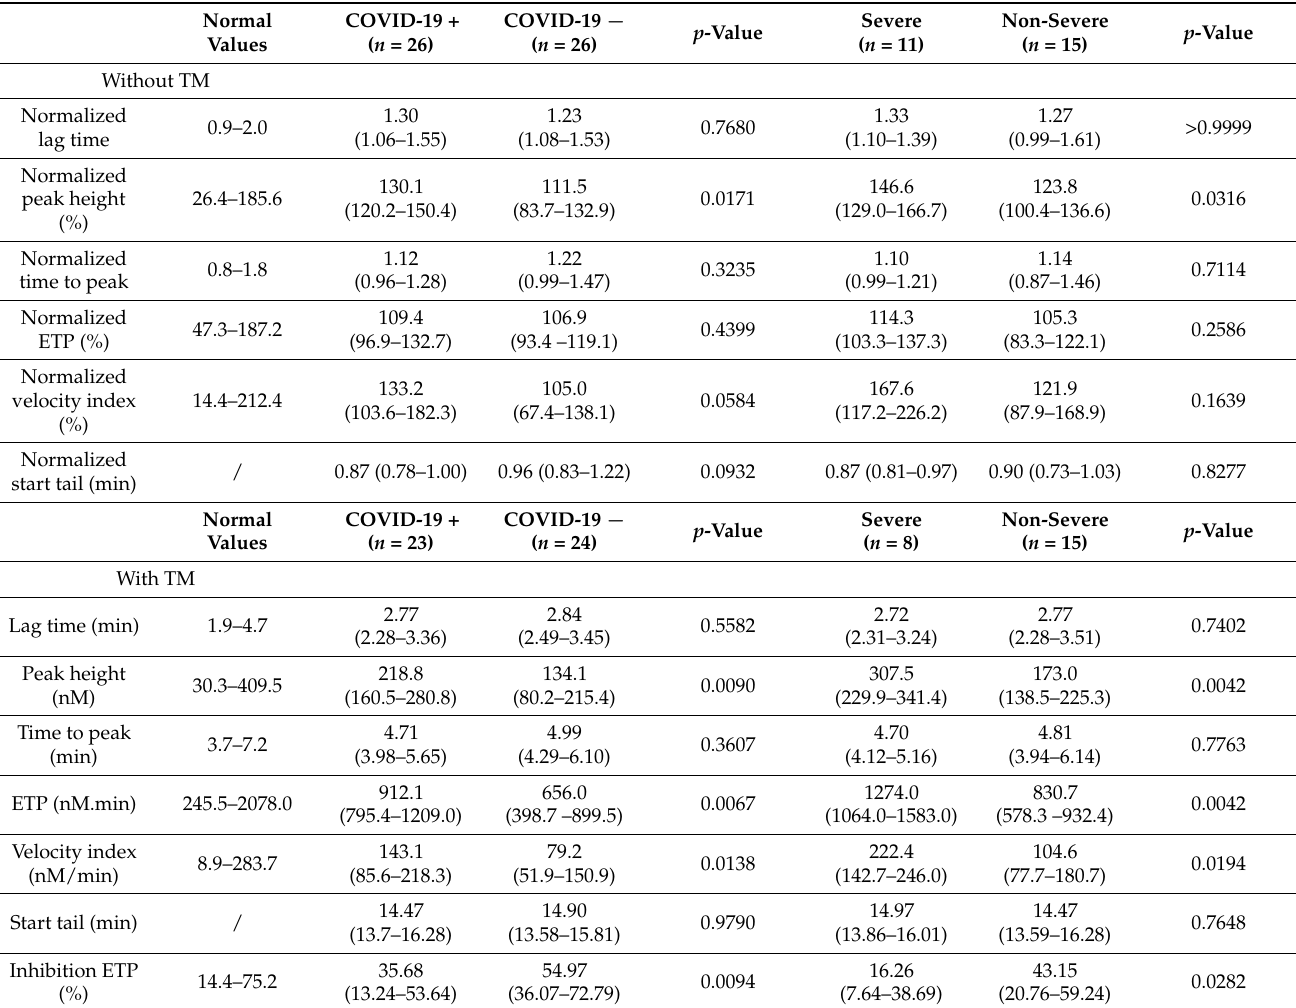
Table 2. TGT results with and without TM for COVID-19-negative and COVID-19-positive patients as well as COVID-19 positive “severe” and “non-severe”